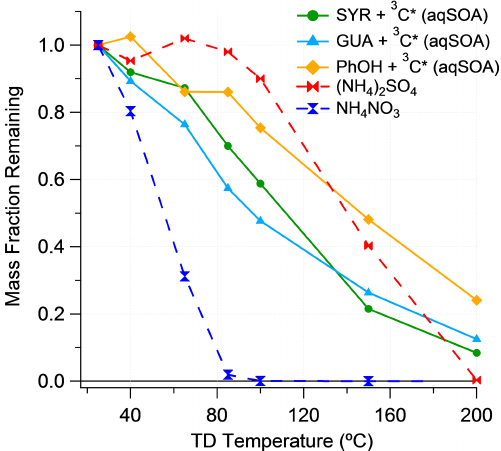
Figure 9. Mass thermograms of ammonium sulfate ((NH 4 ) 2 SO 4 ), ammonium nitrate (NH 4 NO 3 ), syringol (SYR), guaiacol (GUA), and phenol (PhOH) aqSOA formed in 3 C ∗ -mediated aqueous-phase reactions.